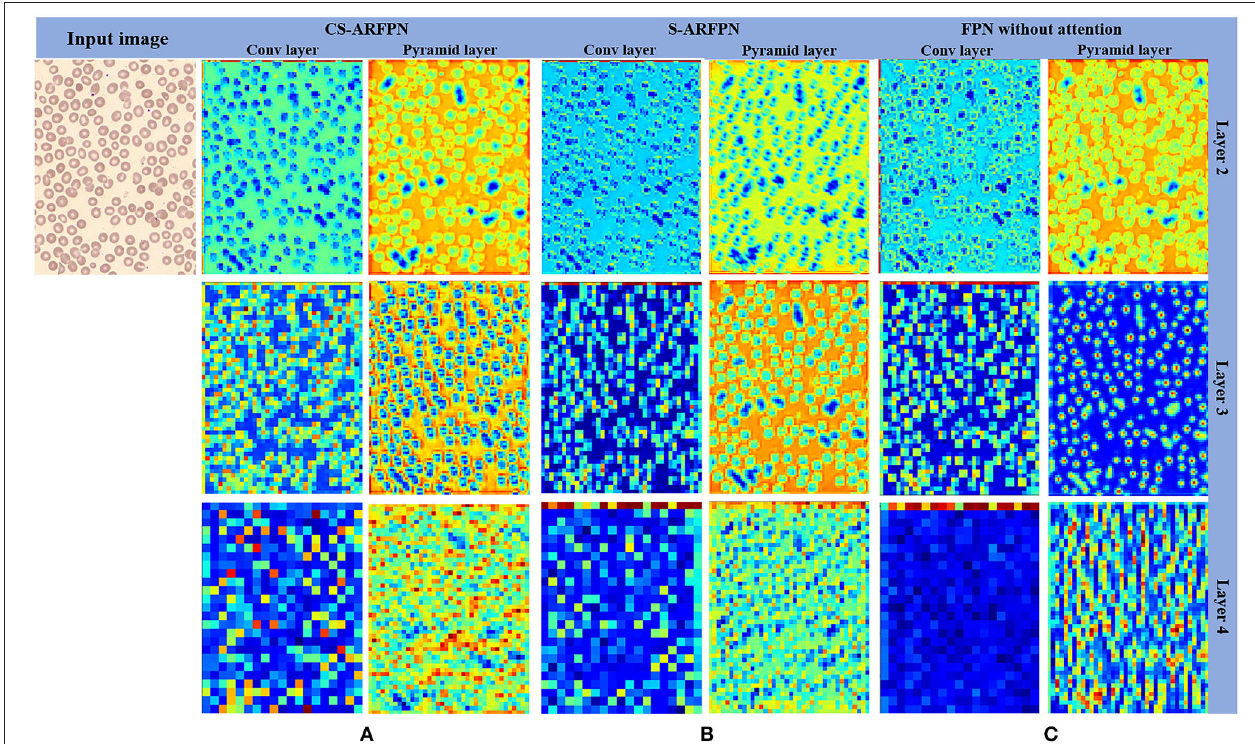
FIGURE 7 | (A) The feature map of the Channel Spatial Attention Residual Feature Pyramid Network (CS-ARFPN) model; (B) The feature map of the Spatial Attention Residual Feature Pyramid Network (S-ARFPN) model; (C) The feature map of the original FPN model. The feature maps extracted from each layer are presented, where warmer colors, such as red and yellow, indicate higher attention weights. The figure, the model with an attention module has a stronger expression of target characteristics and focuses more on the object.